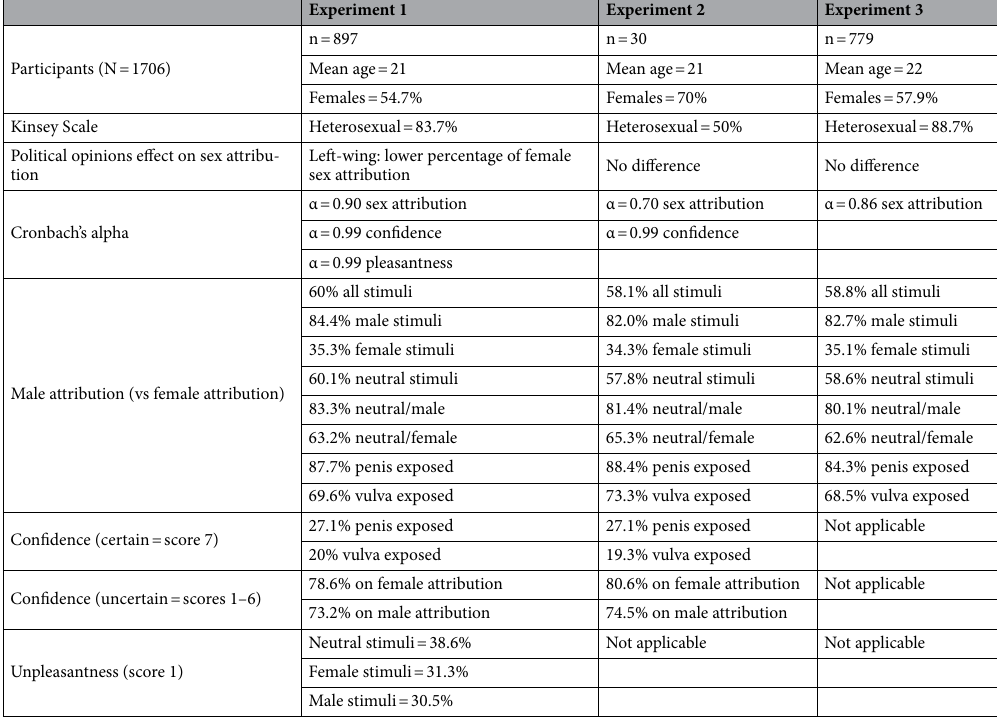
Table 1. Synoptic table of the main results obtained in the three studies (Experiments 1, 2, and